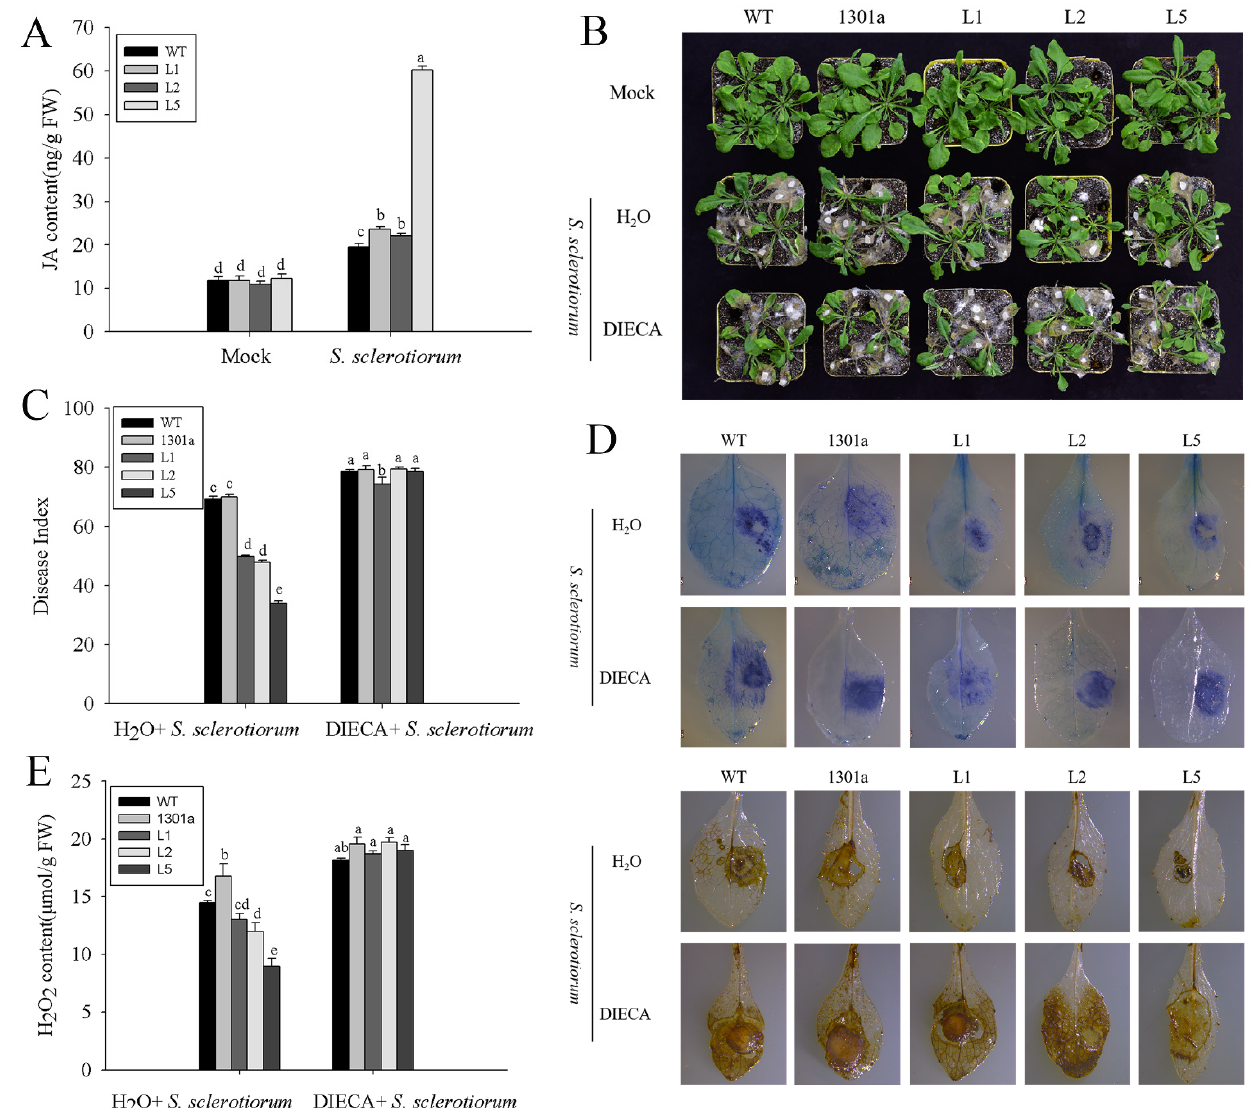
Figure 8. ZmGLP1 transgenic Arabidopsis enhances resistance to Sclerotinia sclerotiorum through the jasmonic-acid-mediated signaling pathway. ( A ) Jasmonic acid contents in the different groups at 6 h post Sclerotinia sclerotiorum infection. ( B ) Phenotypes of the different groups at 3 d post Sclerotinia sclerotiorum , which were pretreated with DIECA for 24 h. ( C ) Disease indexes of the different groups. ( D ) Trypan blue staining and DAB staining of the different groups. ( E ) Detection of H 2 O 2 content of Arabidopsis leaves at 3 d in different groups. Different letters in subfigures ( A , C , E ) indicated significant difference between different samples by Duncan’s post-hoc test. Data are presented as the mean ± SD based on three biological replicates.